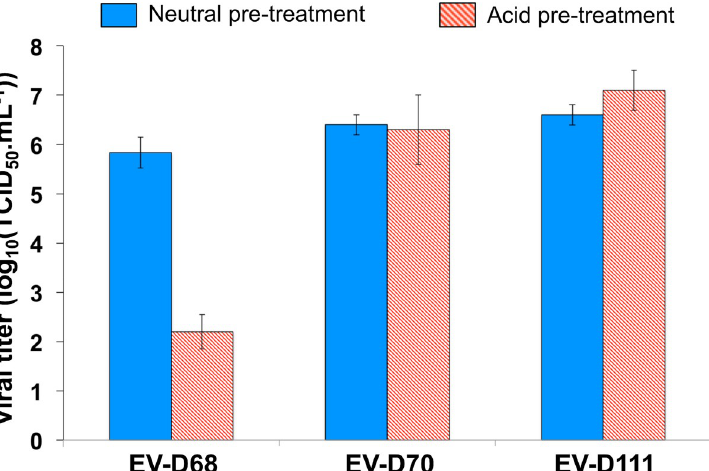
Fig 7. Acid-sensitivity assay. EV-D68 strain Fermon, EV-D70 strain J670/71 and EV-D111 strain OUP-05-059 suspensions were incubated at neutral or acid pH before being titrated on RD cells. The error bars indicate the 95% confidence intervals calculated on triplicates.